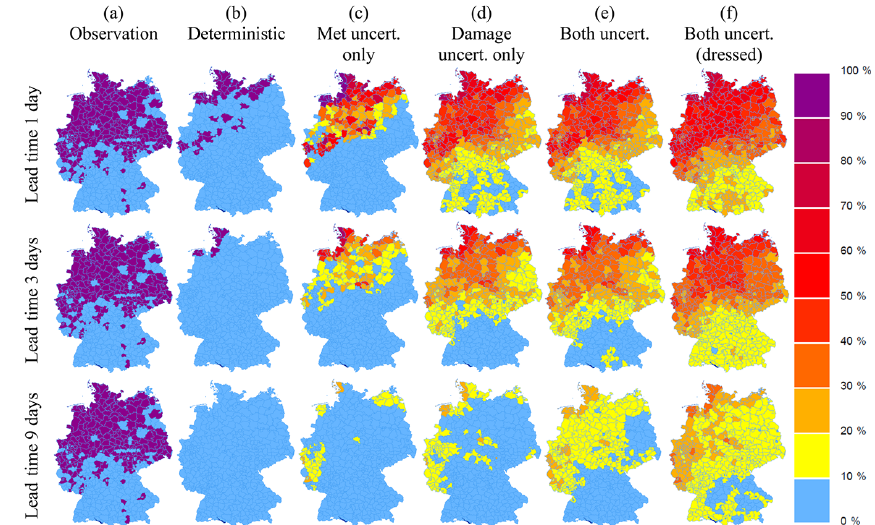
Figure 3. Observed occurrences and forecasted probabilities for loss ratios exceeding 0.0001‰ for 31 October 2006 (winter storm “Britta”). (a) Observation. (b) Deterministic forecast disregarding both uncertainty sources. (c) Only considering the meteorological uncertainty. (d) Only considering the damage-modelling uncertainty. (e) Considering both uncertainties. (f) Considering both uncertainties based on the dressed ensemble ( © GeoBasis-DE/BKG